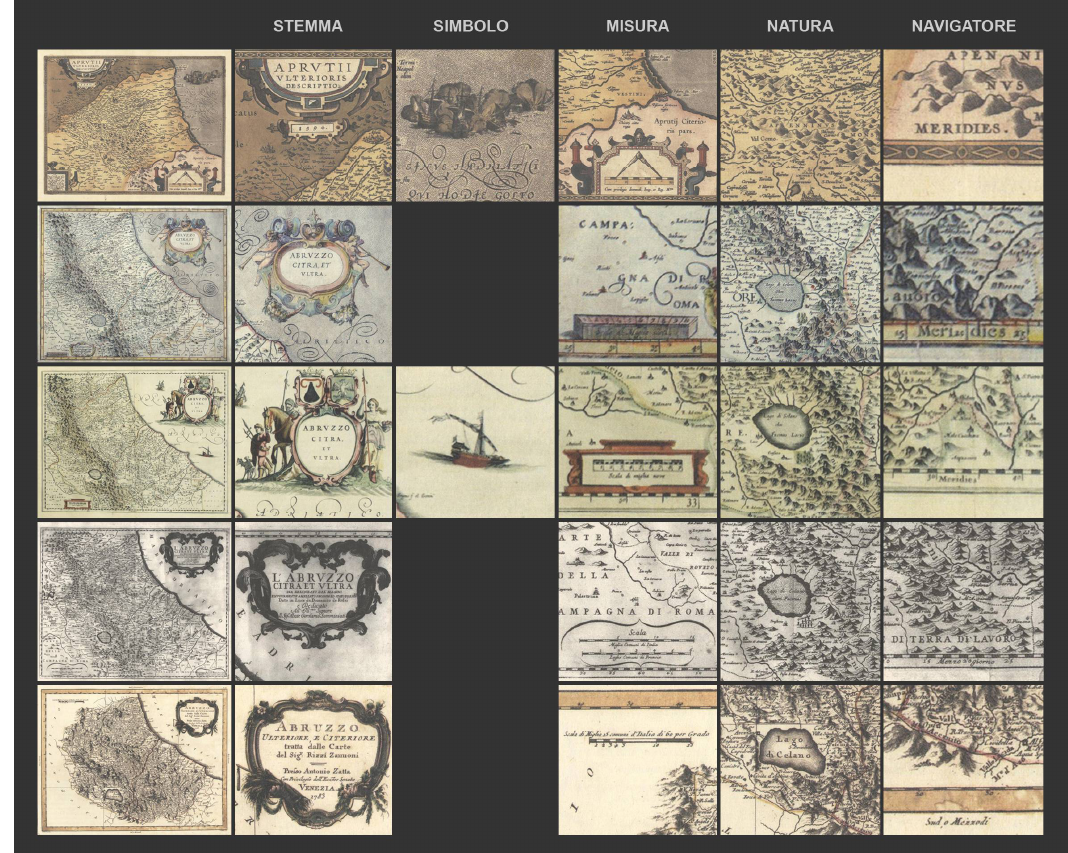
Figure 8. 1. Aprutii Ulterioris Descriptio , Antwerp (1590) by Abramo Ortelio; 2. Abruzzo Ultra et Citra , Bologna (1620) by Giovanni Antonio Magini; 3. Abruzzo Citra et Ultra , Amsterdam (1645) by Joan Bleau; 4. Abruzzo Citra et Ultra , Rome (1714) by Domenico De Rossi and 5. Abruzzo Ulteriore e Citeriore , printed by Antonio Zatta, Venice (1783) by Antonio Rizzi Zannoni (all the ancient cartographs mentioned are kept and cataloged at the State Archives of